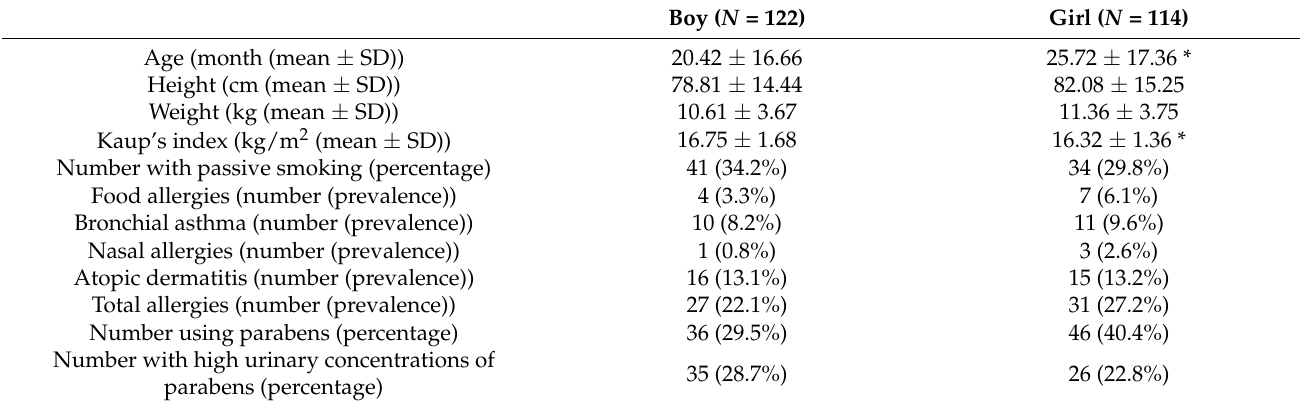
Table 1. Characteristics of children in the present study according to